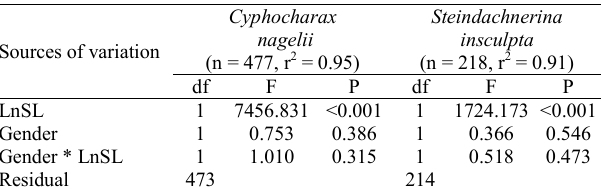
Table 2. Covariance analysis for the natural logarithm (Ln) of total weight (TW - dependent variable) in relation to standard length (SL - covariate) and gender (males and females) factors for Cyphocharax nagelii and Steindachnerina insculpta .